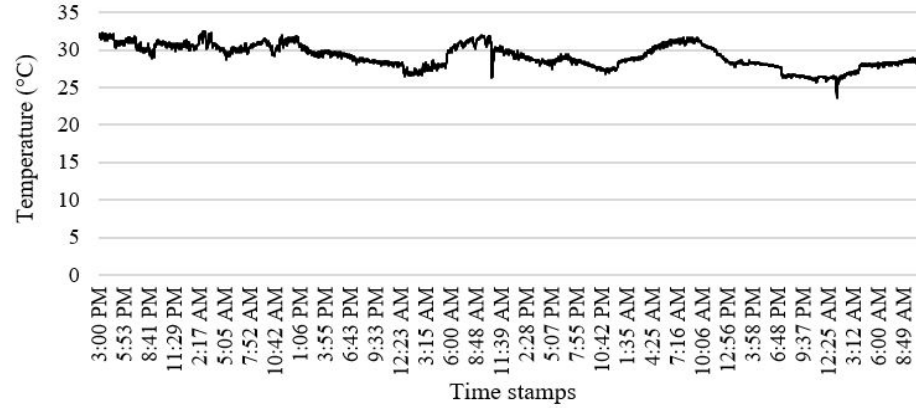
Figure 20. The recorded temperature data trends.